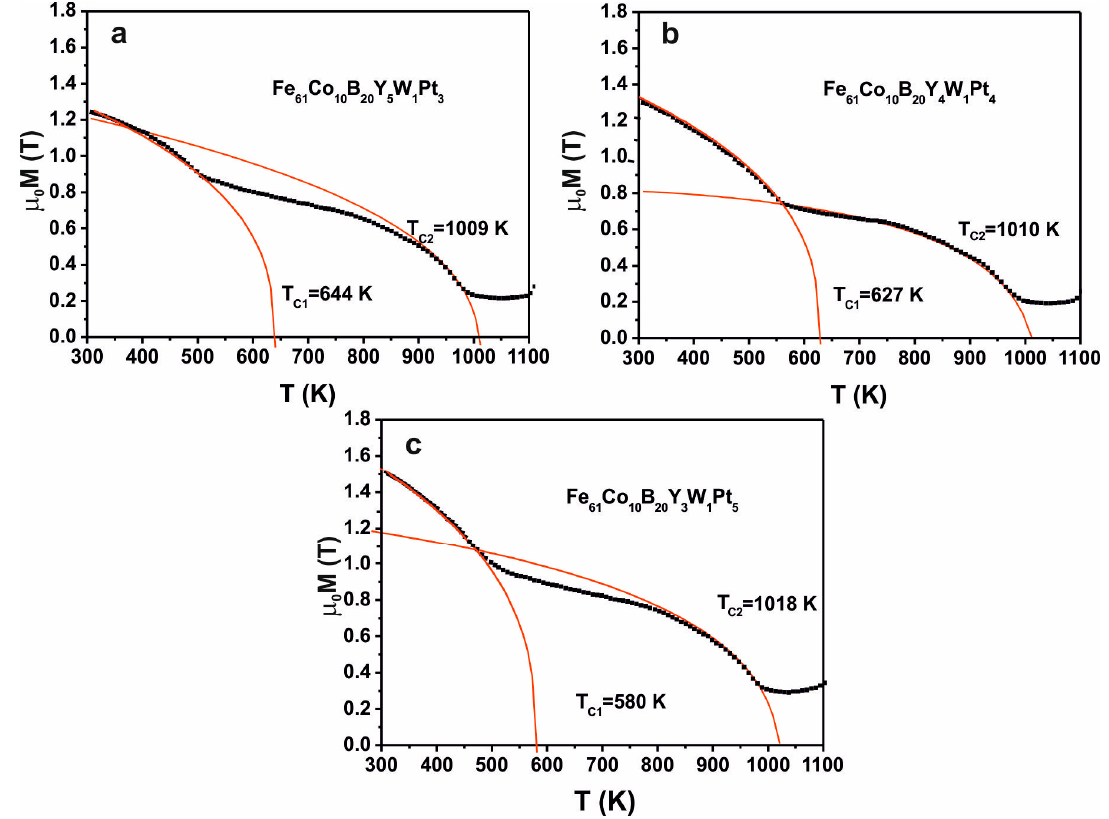
Figure 9. Magnetisation vs. temperature for the as-quenched alloys: ( a ) Fe 61 Co 10 B 20 W 1 Y 5 Pt 3 , (b ) Fe 61 Co 10 B 20 W 1 Y 4 Pt 4 , ( c ) Fe 61 Co 10 B 20 W 1 Y 3 Pt 5 .